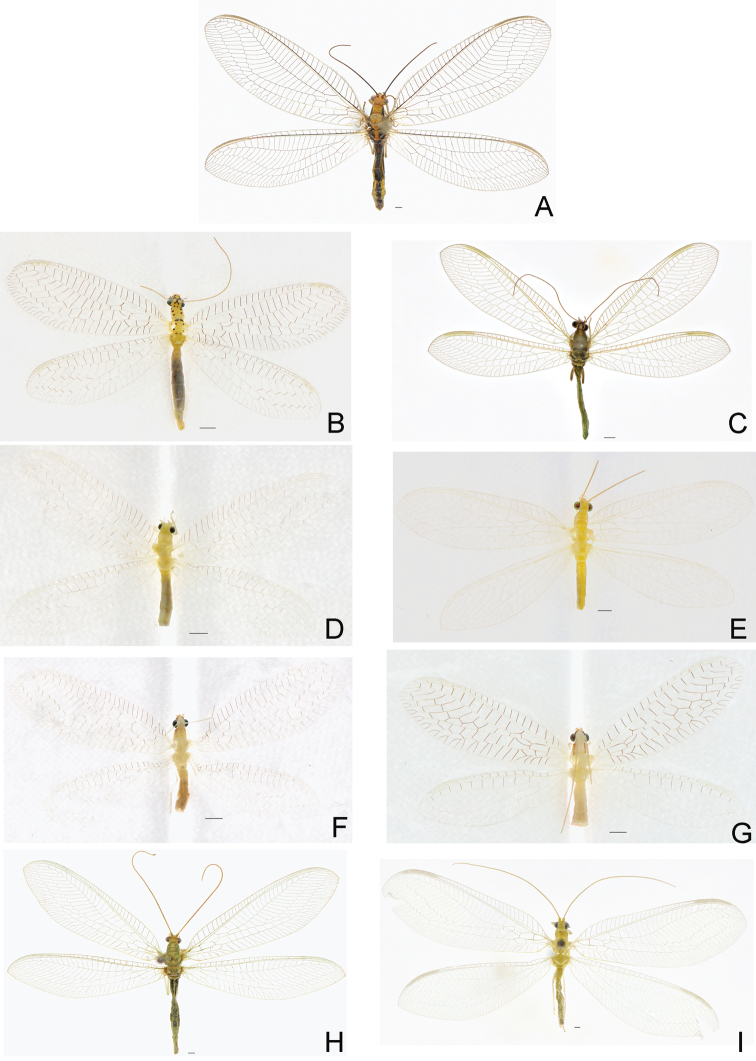
Habitus photographs of species of Chrysopidae newly recorded from Beijing. ANothochrysasinica Yang, 1986 BChrysopaintima McLachlan, 1893 CChrysoperlafurcifera (Okamoto, 1914) DChrysopidiaciliata (Wesmael, 1841) EMalladaflavimaculus Yang & Yang, 1991 FPseudomalladacognatellus (Okamoto, 1914) GPseudomalladaqinlingensis (Yang & Yang, 1989) HNinetagrandis Navás, 1915 INinetashaanxiensis Yang & Yang, 1989. Scale bar: 1 mm.